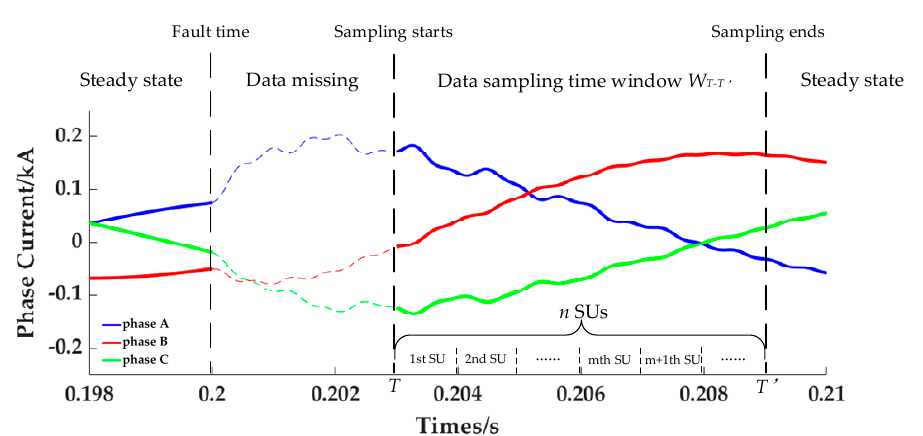
Figure 6. The transient data sampling time window.